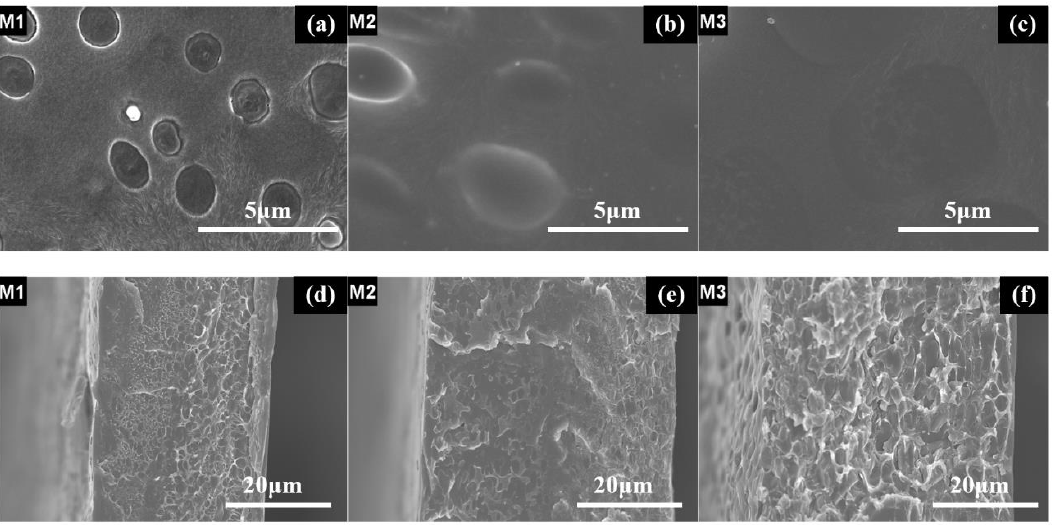
Figure 5. SEM images of the surfaces of M1 ( a ), M2 ( b ), M3 ( c ), and the cross-sections of M1 ( d ), M2 ( e ), M3 ( f ).